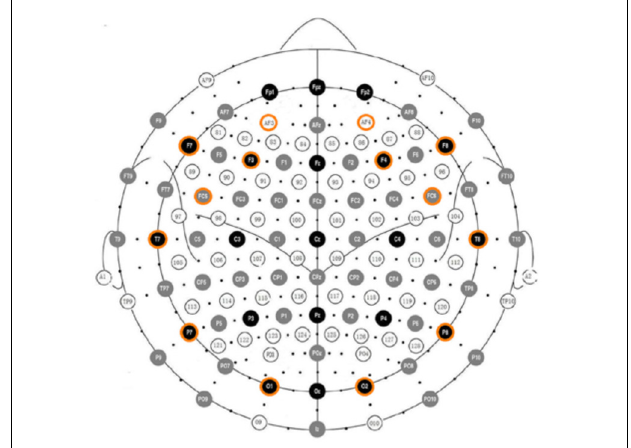
FIGURE 1 | Electrode positions in the Emotiv EPOC according to the international 10–20 system.